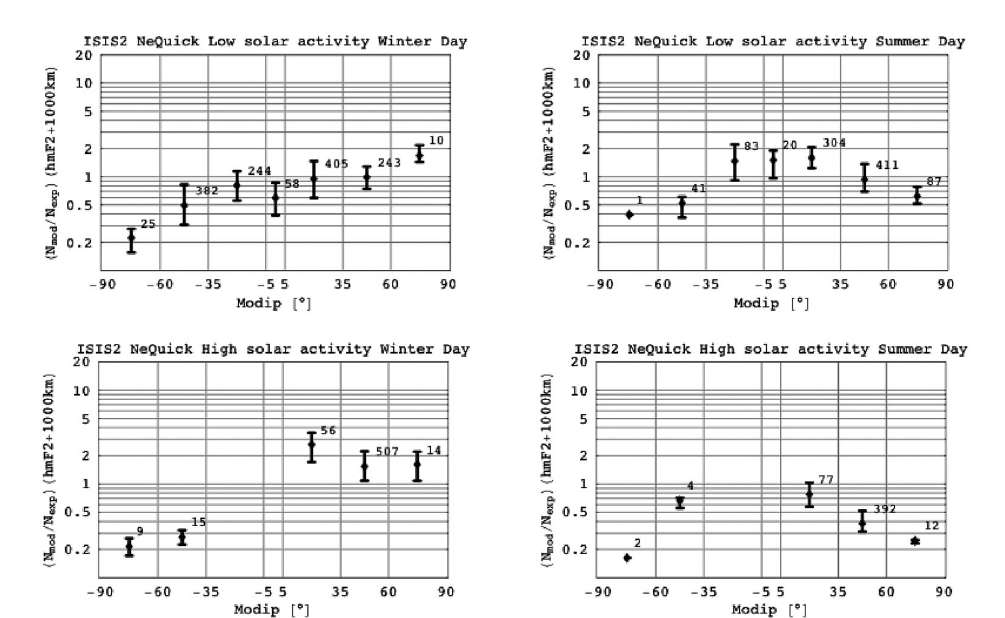
Fig. 18.15. Ratio between NeQuick and experimental electron density 1000 km above hmF 2. Numbers indi- cate the amount of data in each